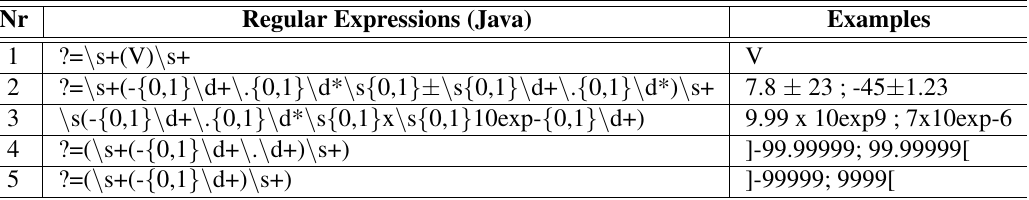
Table 2: Some regular expressions of the rules created and examples of instances.